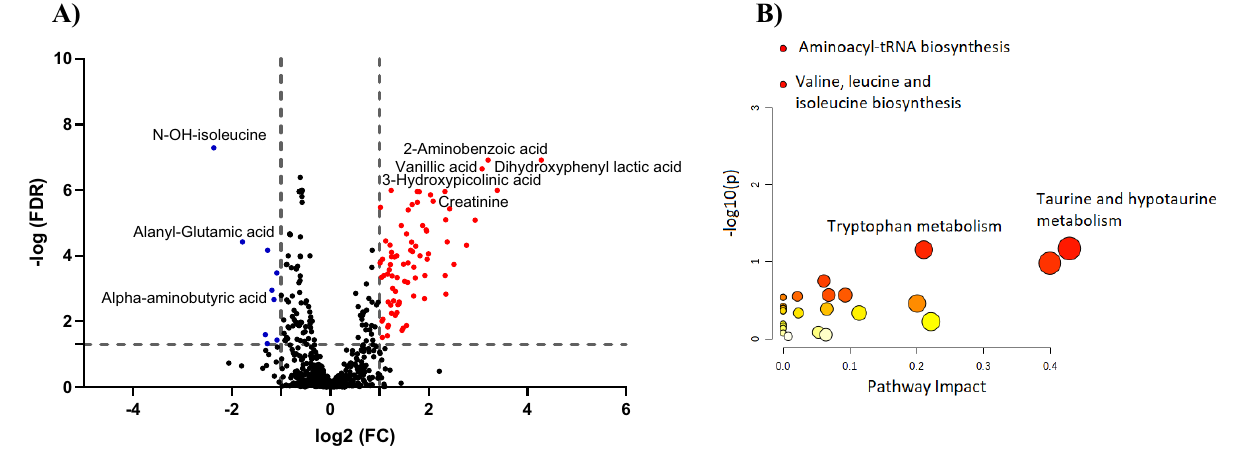
Figure 4. ( A ) Volcano plots of up (red) and down (blue) regulated metabolites in ESRD compared to CKD using FDR and FC cutoffs of < 0.05 and 2, respectively. ( B ) Summary of the most affected pathways. The node color and size are based on the p-value and the pathway impact value,